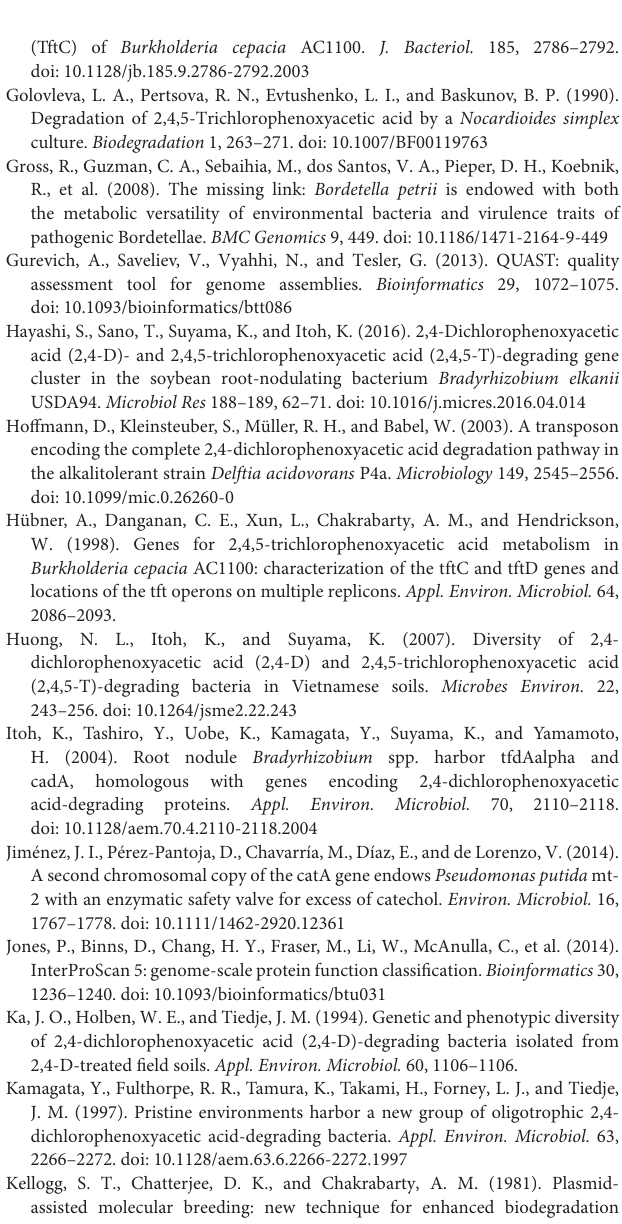
Supplementary Table 1 | Enzymes in KEGG pathways for degradation of 2,4-D and 2,4,5-T along with relevant characteristics. Supplementary Table 2 | Statistics of sequencing after demultiplexing and filtering. Supplementary Table 3 | Genes encoding KEGG enzymes for degradation of 2,4-D and 2,4,5-T in the four isolated species. Those with an identity more than 45% with the homolog from the KEGG database are marked. Supplementary Table 4 | Pairwise identities between tfd enzymes of the isolated species and of related species. Identities more than 50 and 95% are in orange and red,